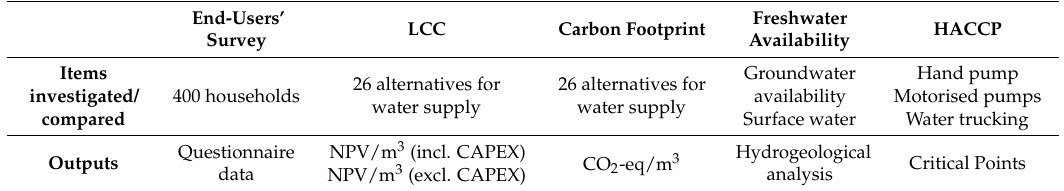
Table 2. Summary of the different tools used for the comparative assessment. LCC: life-cycle costing; HACCP: hazard analysis and critical control points; NPV: net present value; CAPEX: capital expenditure. * N/A: